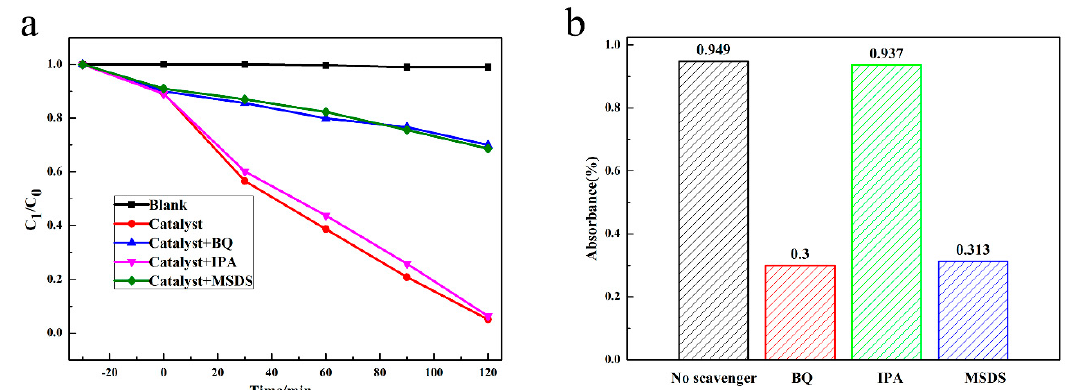
Figure 6. The active matter catching tests for degradation of CIP with 1.0AgBr / Ag 2 MoO 4 @InVO 4 composite photocatalyst in visible light. ( a ) Degradation curve and ( b ) degradation rate of CIP with different capture agent.